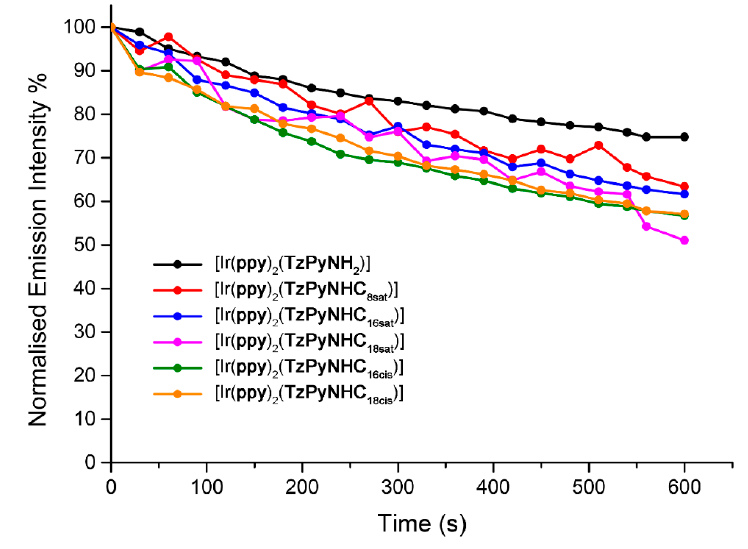
Figure 7. Photobleaching analysis in PBS (2% DMSO) of the reported iridium complexes.